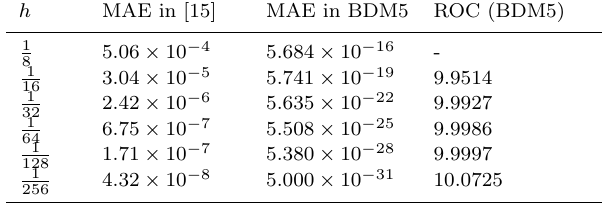
Table 10. Observed MAE of BDM5 and [15] and ROC of BDM5 for Example 5.